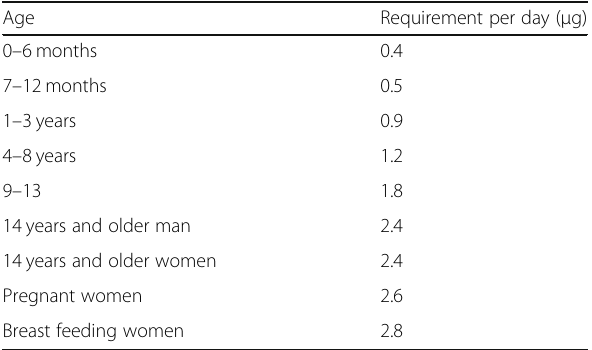
Table 1 Age-wise requirement of vitamin B 12 (microgram) in human (IOM 1998) Age Requirement per day ( μ